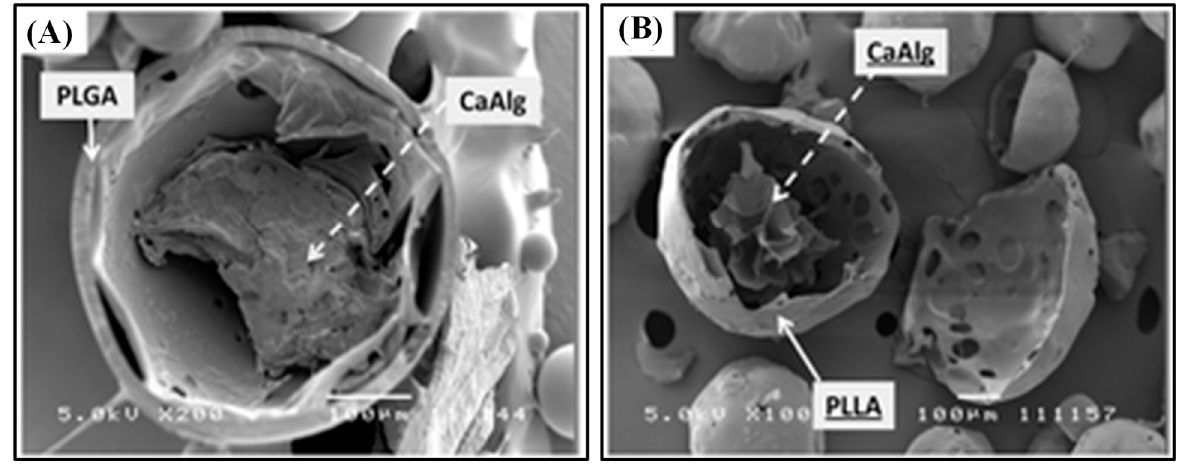
Figure 1. SEM image of a cross-sectioned ( A ) alginate–PLGA particle, and ( B ) alginate–PLLA particle. The scale bar is 100 μ m. Reproduced with permission from [32].